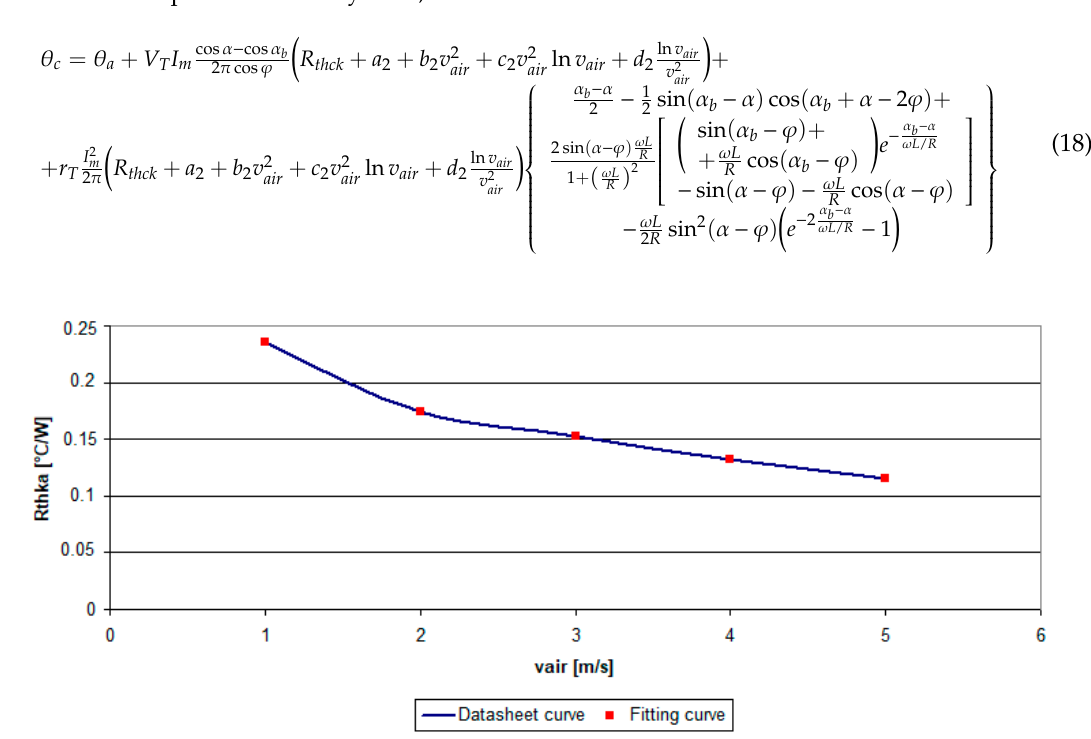
Figure 4. Comparison between datasheet and fitting curve for the heatsink-environment thermal resistance variation against air speed in the case of forced cooling.